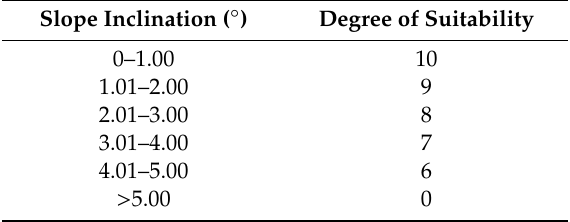
Table 1. Reclassification degrees of suitability for inclinations of slopes.